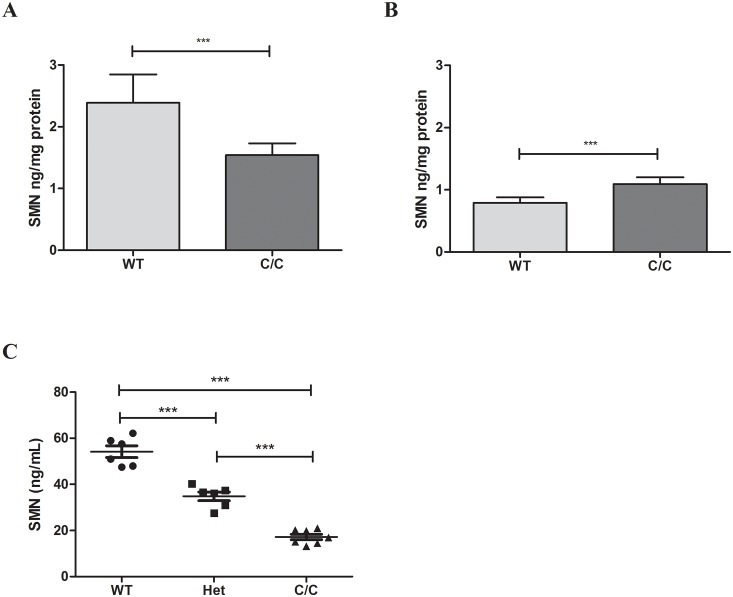
SMN protein levels in tissues of C/C-allele and WT mice measured by SMN-ECL and SMN-ELISA.Protein levels were measured in the spinal cord of C/C-allele and WT mice using (A) SMN-ECL and (B) SMN-ELISA. Both assays showed a statistically significant difference in SMN levels between WT and C/C-allele mice (p < 0.0001). (C) SMN protein levels in the whole blood of C/C-allele, WT and heterozygous mice measured by SMN-ECL.